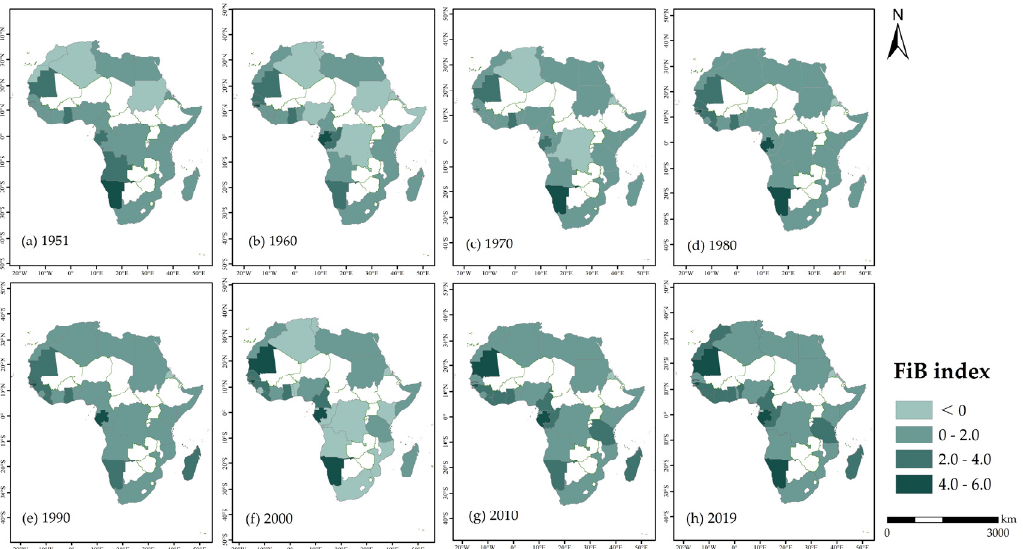
Figure 7. Spatial distribution of Fishing-in-Balance (FiB) index in Africa during 1951–2019, by decade. Note: According to the calculation method of FiB, this paper takes 1950 as the base year, so the FiB values of African countries in 1950 are all 0, which cannot present the spatial distribution. Therefore, the FiB values of 1951 are taken in this figure to present the main spatial distribution in this period, and the results were calculated according to Formula (2).